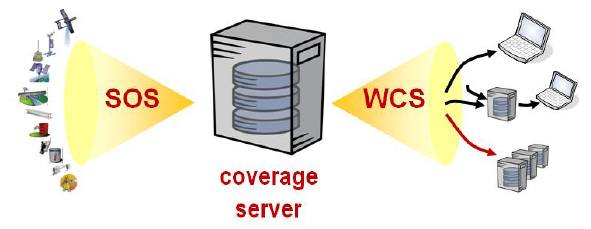
Figure 12. Complementary purposes of SOS and WCS: upstream sensor collection (left) and downstream download, processing, and visualization (right)